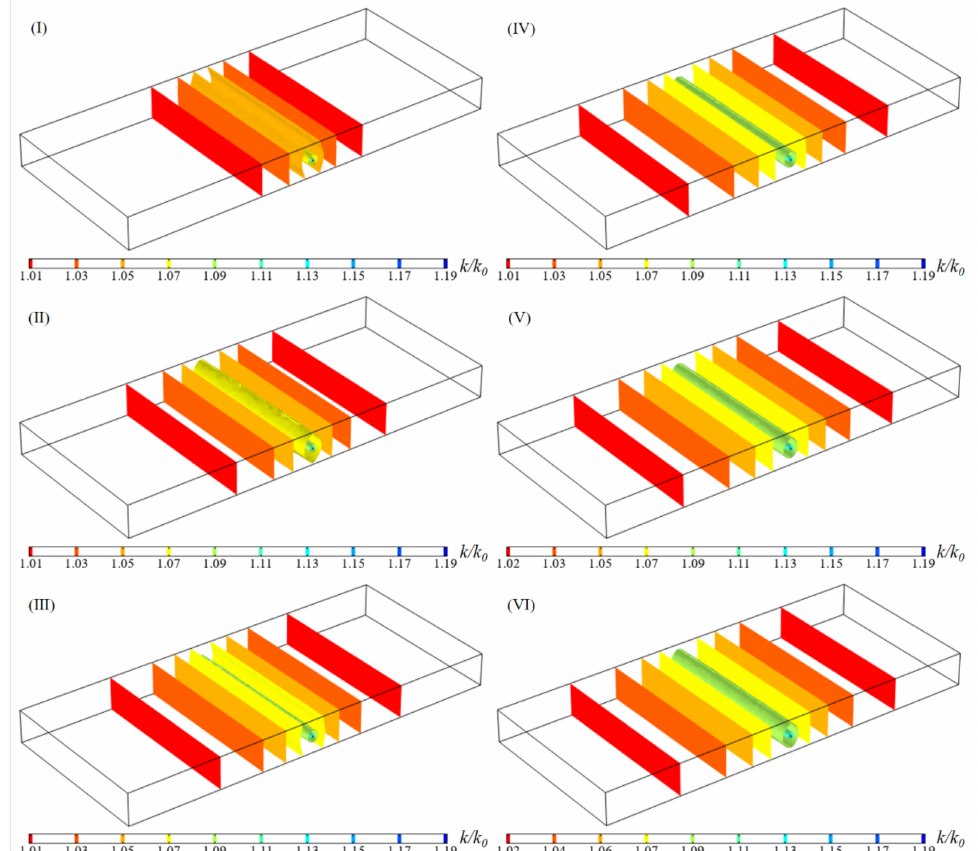
Figure 10. Three-dimensional cloud chart of coal permeability distribution around boreholes at different drainage times: ( I ) 50 d; ( II ) 100 d; ( III ) 150 d; ( IV ) 200 d; ( V ) 250 d; ( VI ) 300